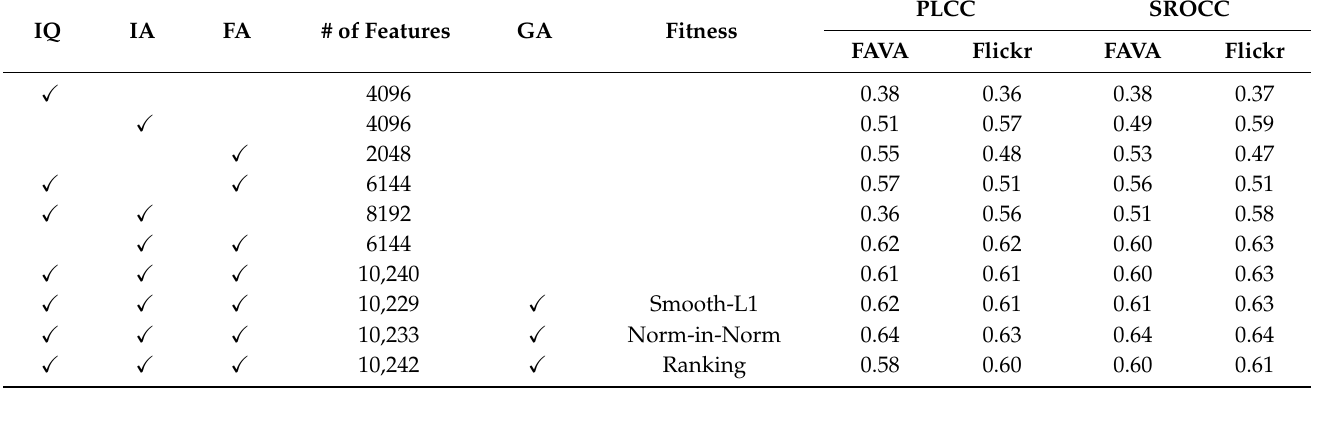
Table 2. The Pearson linear correlation coefficient (PLCC) and the Spearman rank-order correlation coefficient (SROCC) of the aesthetic quality prediction for each database by extracting perceptual features from the whole image.